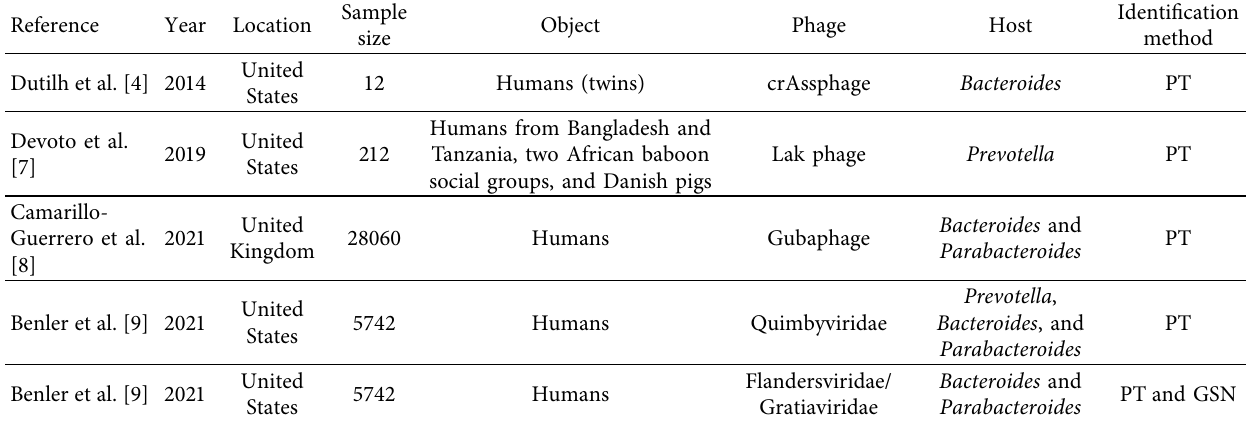
Table 1: Human intestinal phage